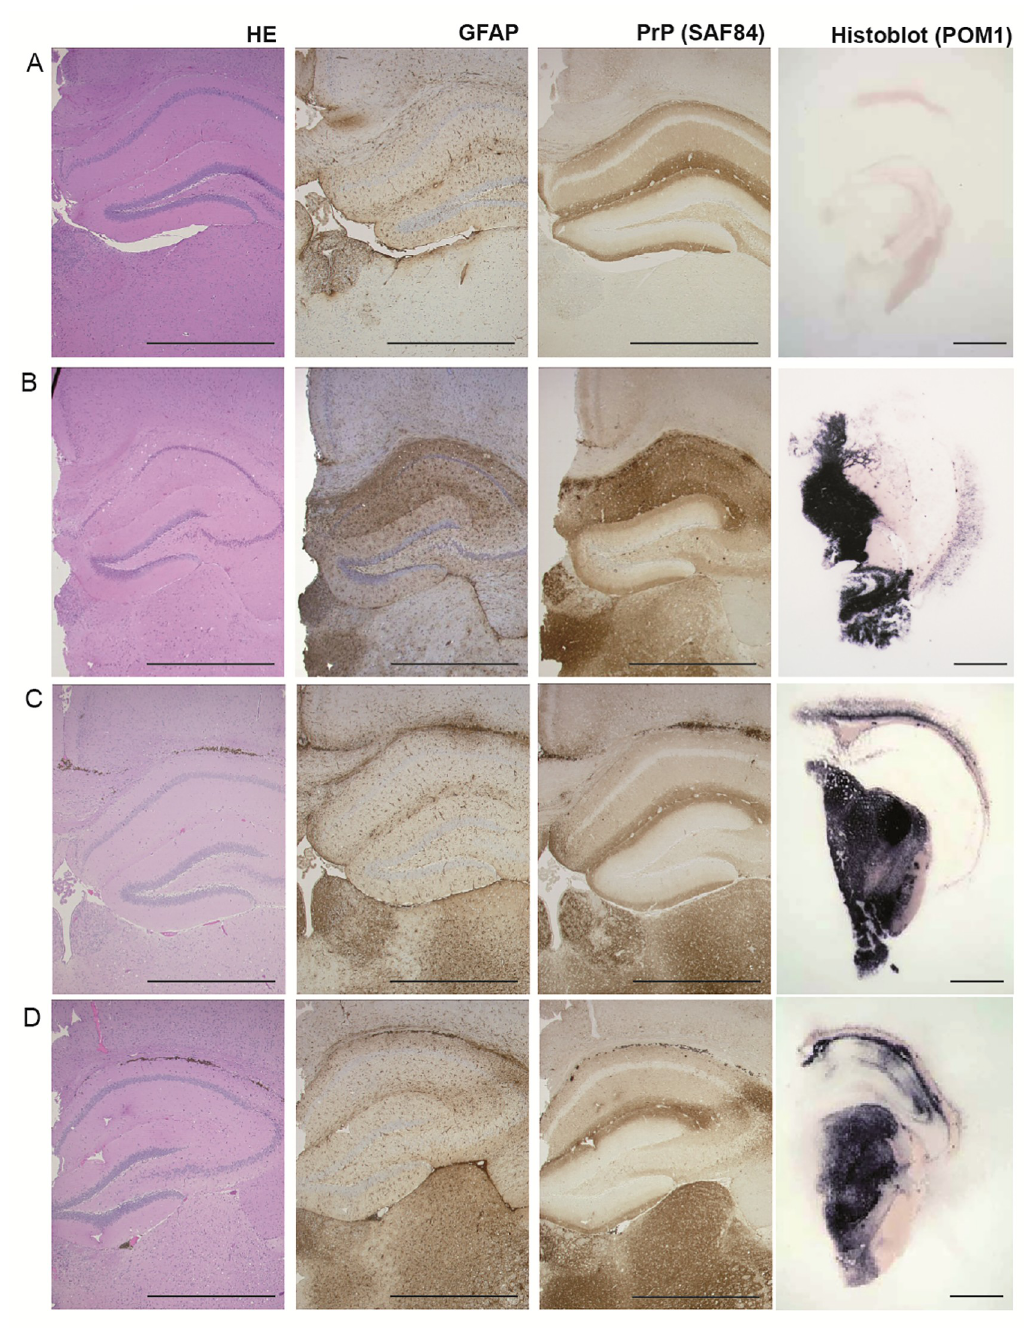
Fig 3. Pathology of hippocampus, medial habenular and thalamic nuclei from Tg (SHaPrP) mice. Non-inoculated mice (A) show no evidence of vacuolation, PrP Sc deposition or gliosis. Mice inoculated with 263K prion-infected hamster brain homogenate (B) , inoculated with PSR1 beads incubated with plasma pools from symptomatic hamster at 117–118 dpi (C) and at 143 and 154 dpi (D) show vacuoles in the HE stained section (see also S2 and S3 Figs), PrP c and PrP Sc deposition as visualized by the PrP antibody SAF84 and astrocytic gliosis as evidenced by an antibody directed against GFAP. Histoblot analysis was used to show PrP Sc deposition after proteinase K digestion and staining with POM1. (Scale bars: 1 mm).